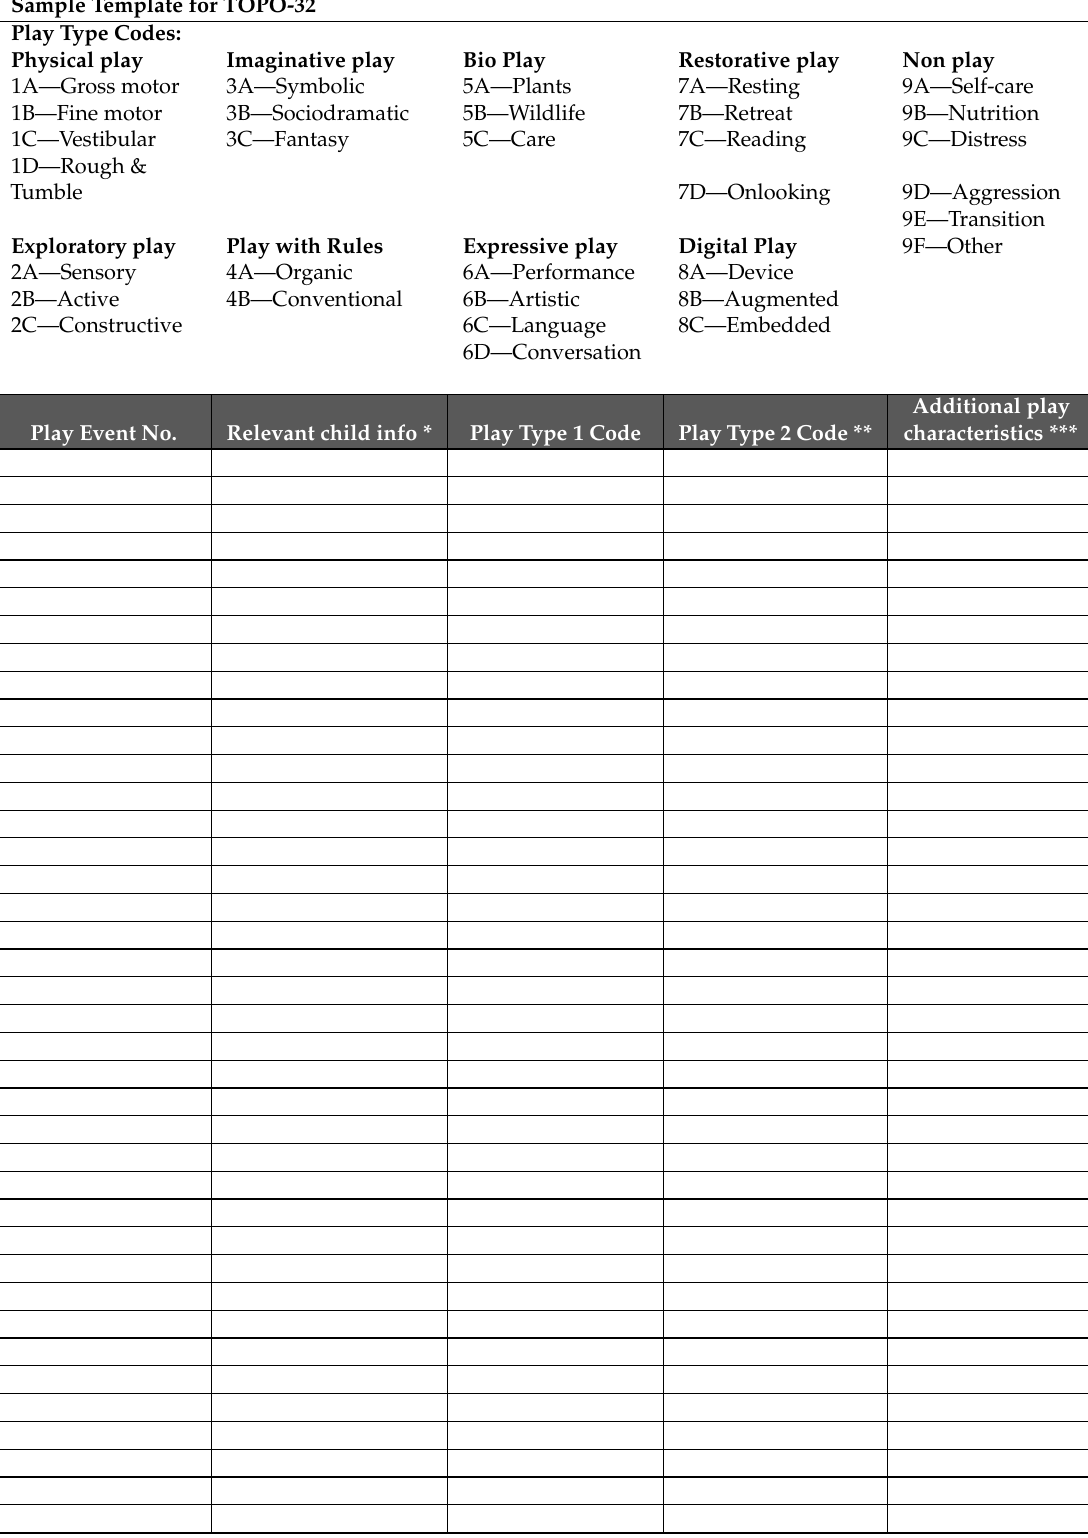
Table A2. Sample Template for TOPO-32 (Expanded